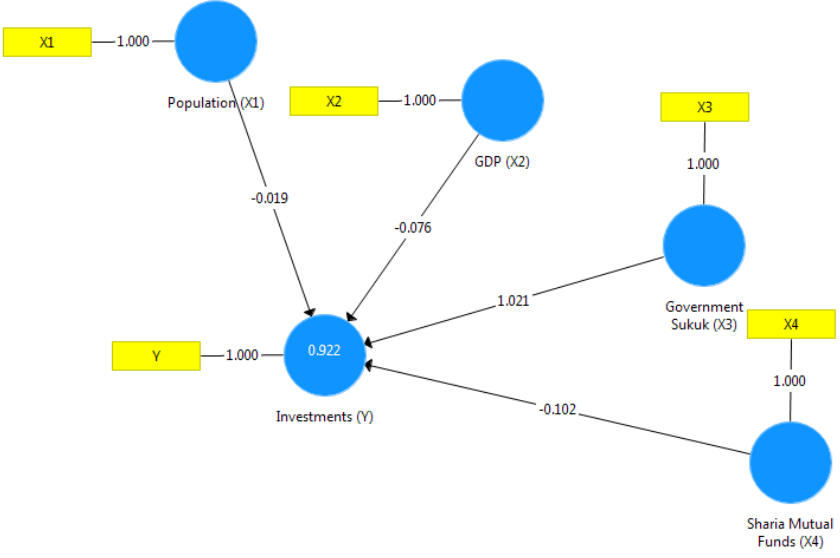
Fig. 1. Overall Model with Coefficient